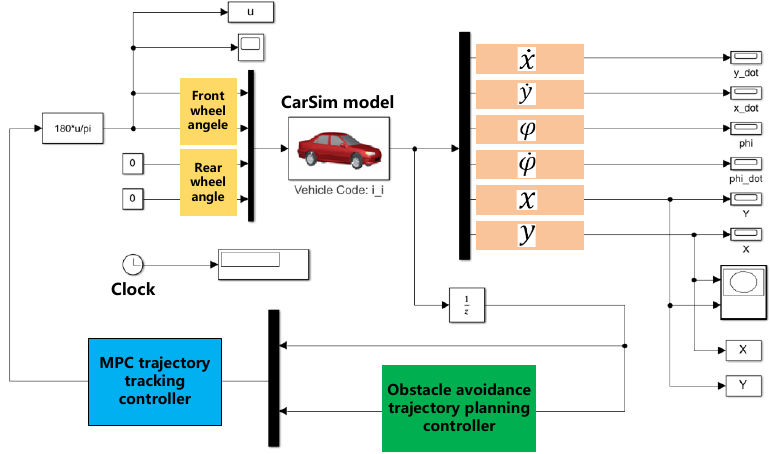
Figure 14. CarSim/Simulink co-simulation model. Figure 14. CarSim / Simulink co-simulation